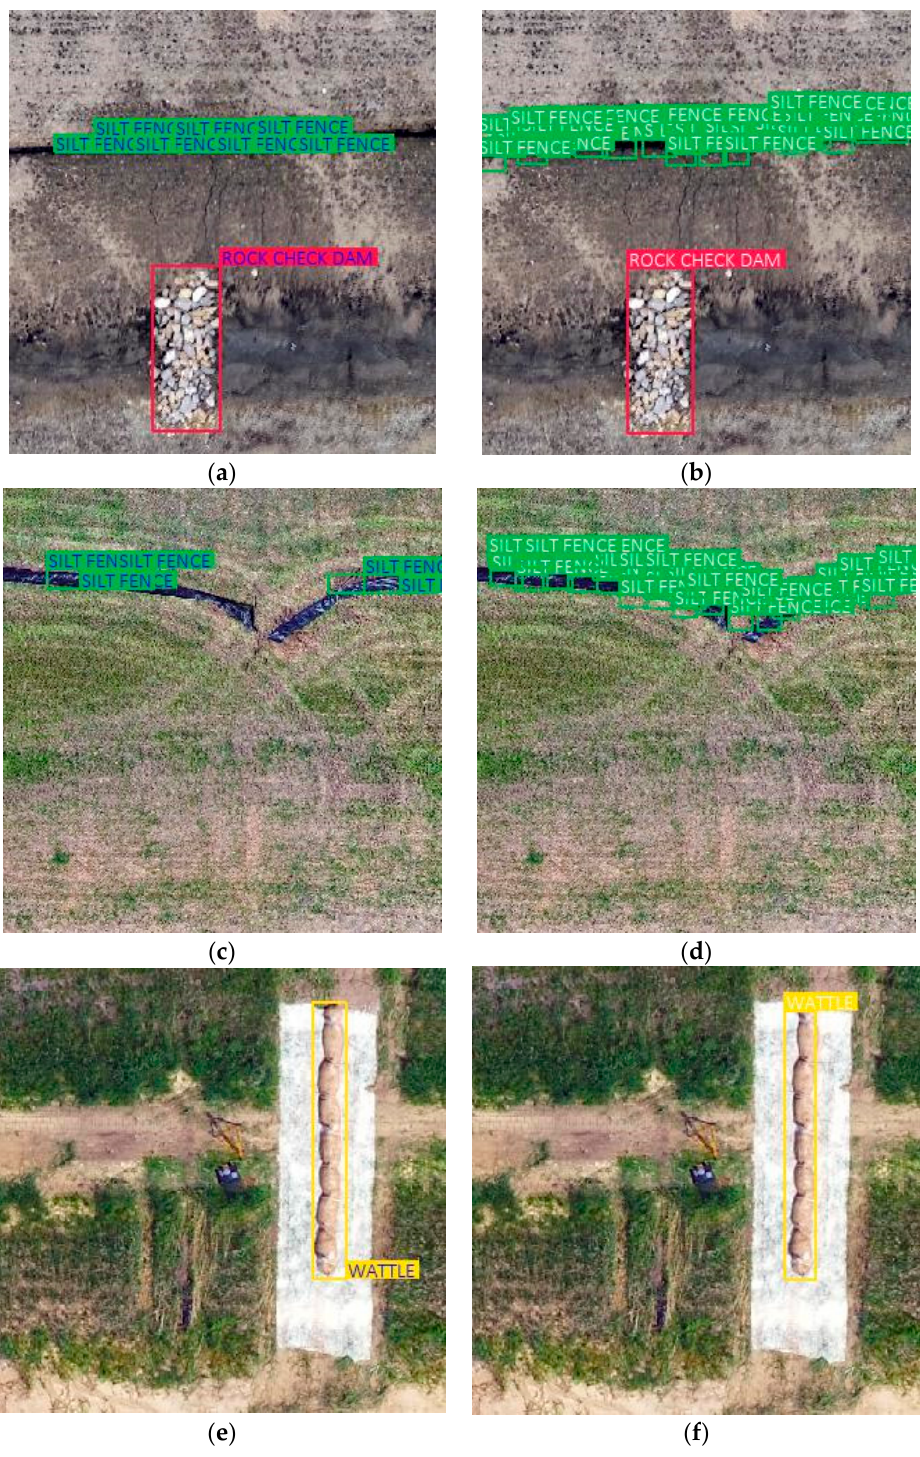
Figure 7. Comparison of validation results. ( a ) Original image; ( b ) validation result; ( c ) original image; ( d ) validation result; ( e ) original image; ( f ) validation result.